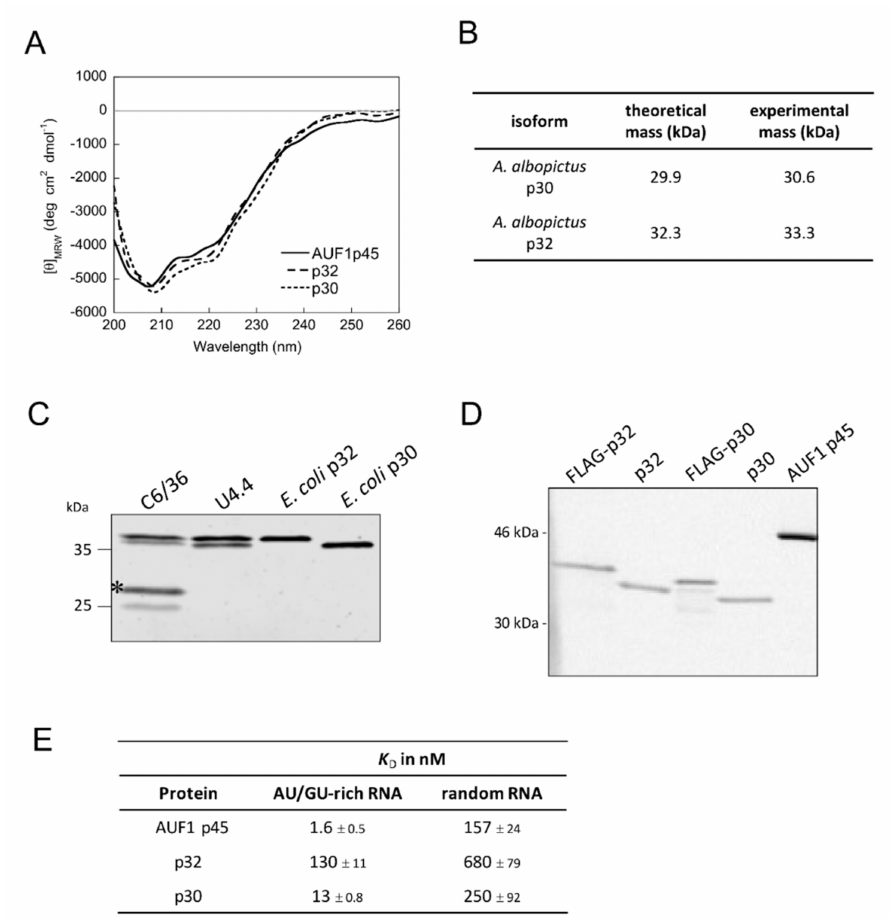
Figure 6. Characterization of mosquito proteins p30 and p32. ( A ) Far-UV circular dichroism (CD) spectra of AUF1 p45 and mosquito p30 and p32 were recorded. The acquired data were normalized to mean residue weight (MRW) ellipticities. The CD data for AUF1 p45 were taken from [16]. ( B ) Summary of the analytical ultracentrifugation experiments demonstrating that mosquito proteins p30 and p32 are monomeric proteins (see Supplementary Figure S3). ( C ) Detection of squid isoforms p30 and p32 in cell extracts of mosquito cell lines C6 / 36 and U4.4. An antibody that was raised against the full-length p32 protein (purified from E. coli ) was applied. The asterisk indicates bands that most likely correspond to degradation products of p30. ( D ) In vitro methylation assay with PRMT1 and di ff erent protein preparations. Equal amounts (1 pmol) of mosquito proteins p30 and p32 that were purified from E. coli , as well as FLAG-p30 and FLAG-p32 proteins that were purified from C6 / 36 cells, were methylated by PRMT1. AUF1 p45 (13 pmol) that was purified from E. coli served as a positive control. The samples were taken after 2 h and analyzed by SDS–PAGE and phosphor imaging. ( E ) RNA binding a ffi nities of human AUF1 p45 and mosquito proteins p30 and p32 to an AU / GU-rich RNA and a randomly composed RNA. Dissociation constants and standard deviations derived from at least three measurements. The binding data for AUF1 p45 were taken from